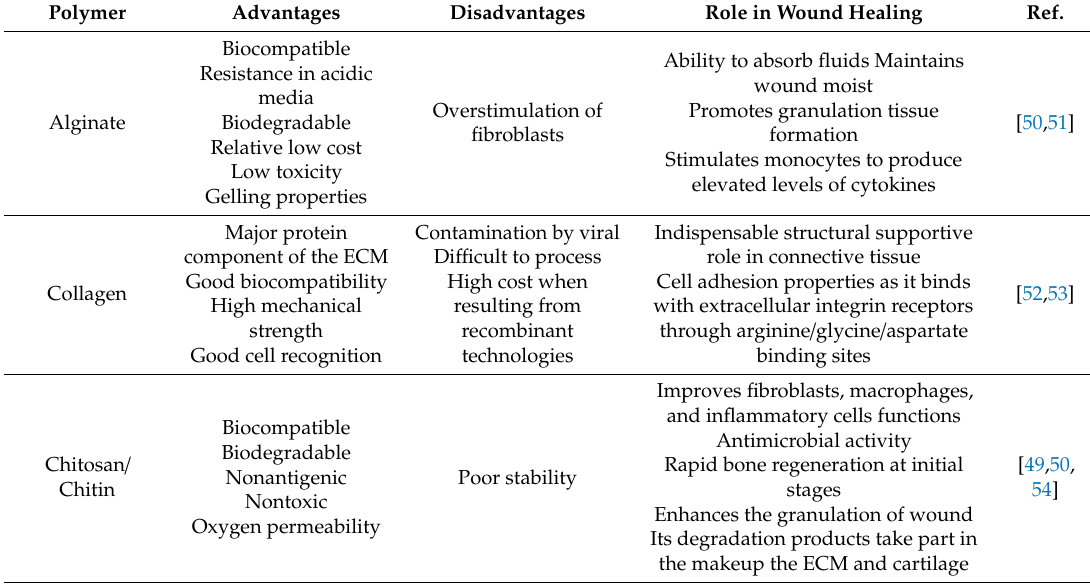
Table 3. Natural